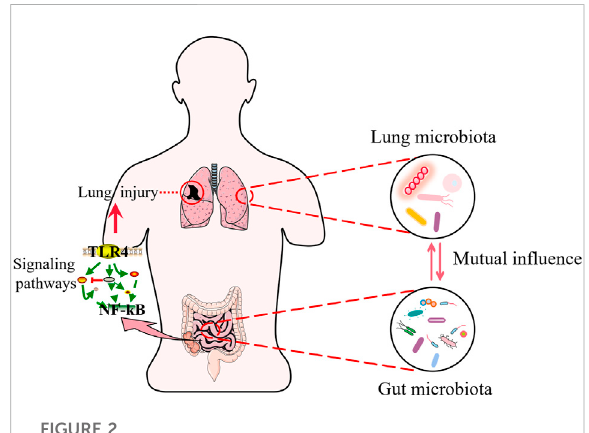
FIGURE 2 Sepsis andlung injury. Intestinalmicrobiotainteractwithlung microbiota during sepsis. The gut microbiota regulates signaling pathways and participates in sepsis induced lung